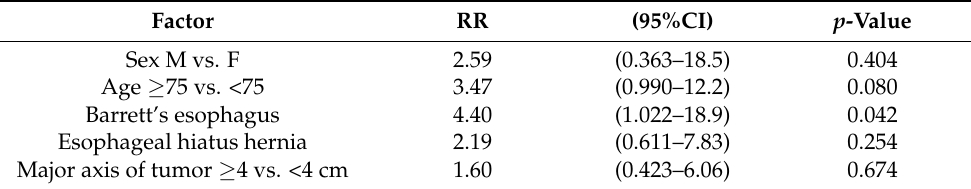
Table 3. Potential risk factors for discordance among the classification categories of esophagogastric junction cancer.